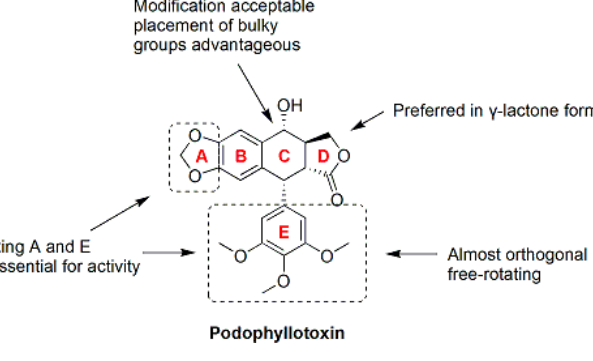
Figure 7. SAR of podophyllotoxin [94].